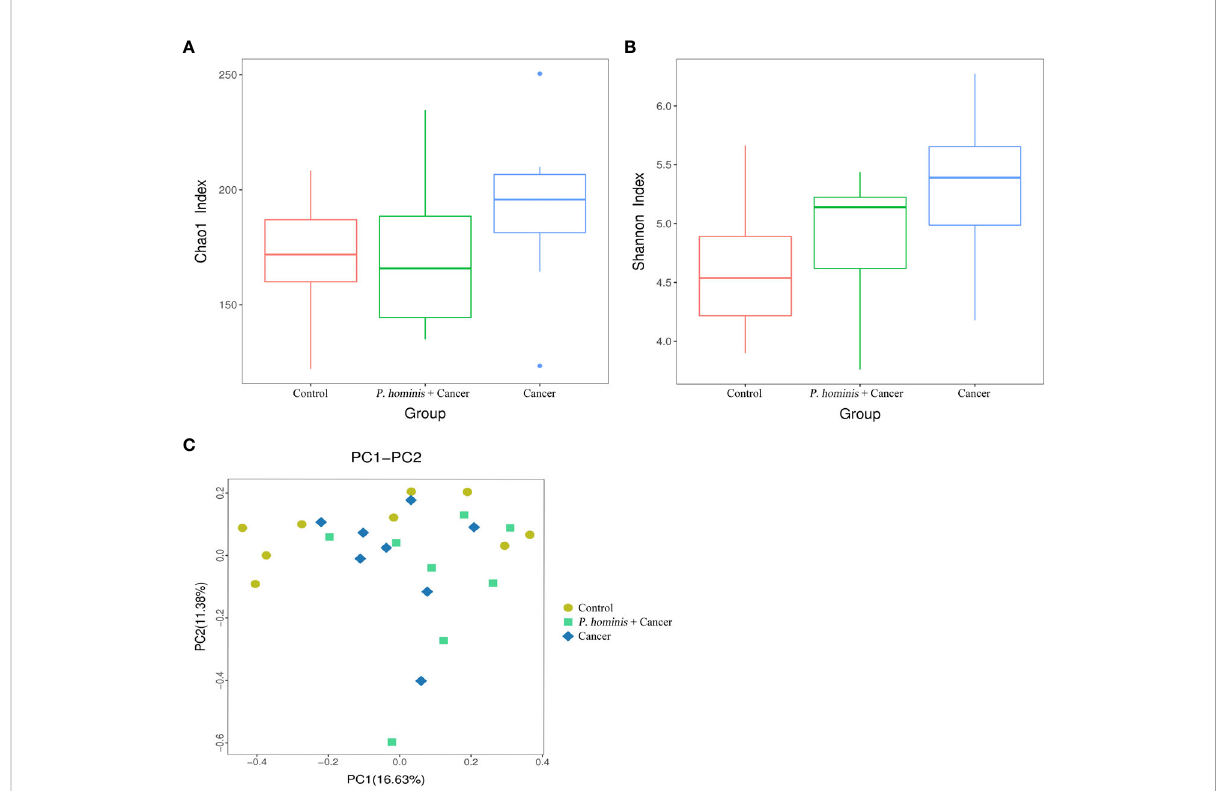
FIGURE 1 Structure, richness, and diversity of the gut bacterial community of the control group (Control), uninfected patients with colon cancer (Cancer), and patients with colon cancer who were infected with P. hominis ( P. hominis+ cancer). (A) Comparison of the richness of the microbiota in the fecal samples among the Control, Cancer, P. hominis+ cancer groups based on the Chao1 index. (B) Comparison of the fecal diversity of the microbiota among the Control, Cancer, and P. hominis+ cancer groups based on the Shannon index. (C) PCoA of gut microbiota among the Control, Cancer, and P. hominis+ cancer groups. P < 0.05 indicates that the difference between two groups was statistically signi fi